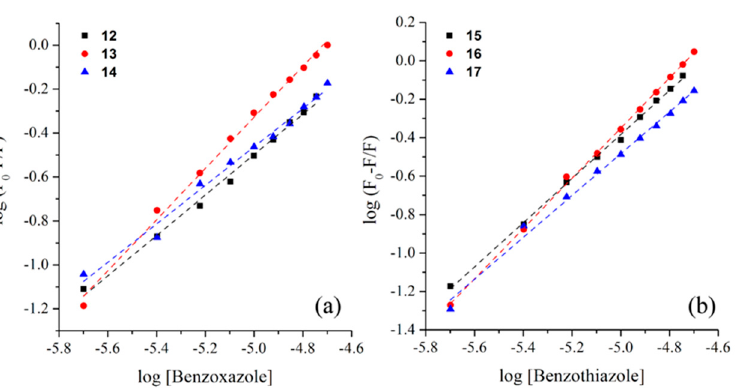
Figure 5. Double logarithm plots for the K A and n calculations of ESIPT fluorescent lipophilic (a) benzoxazoles 12 – 14 and (b) benzothiazoles 15 – 17 .. ( a ) benzoxazoles 12 – 14 and ( b ) benzothiazoles 15 – 17